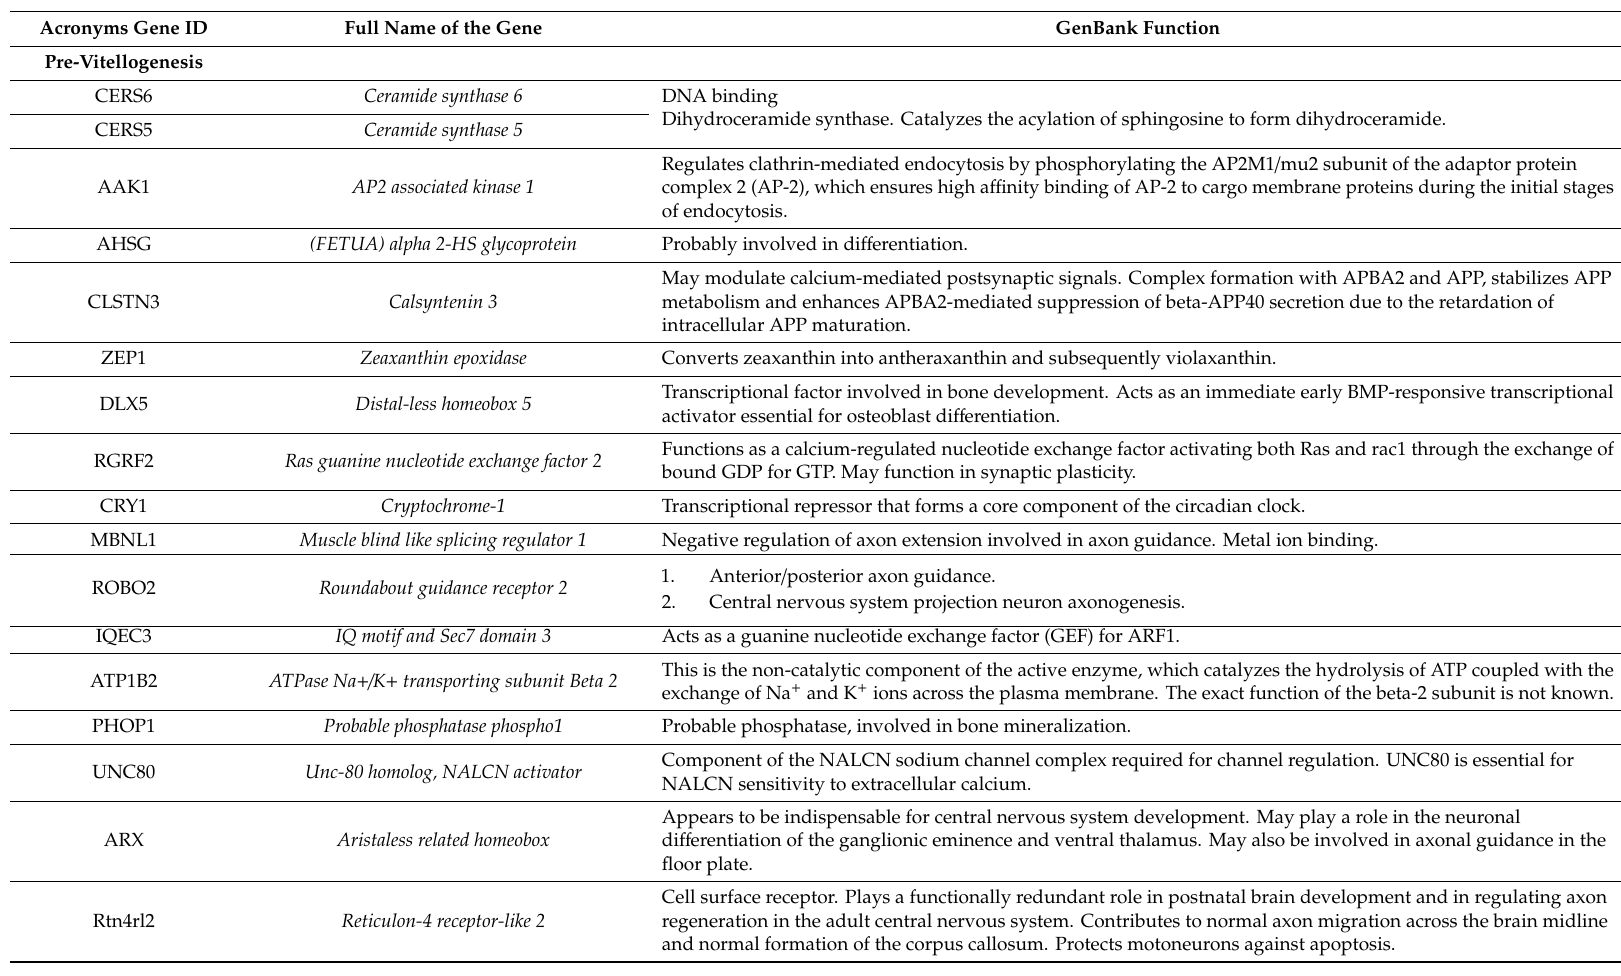
Table 1. In the whole-brain mRNA level list of gene names and functions, changes are di ff erent in PVTL and HVTL, which supports some connections and functions of those genes in oogenesis [55]. All of the information is based on GenBank